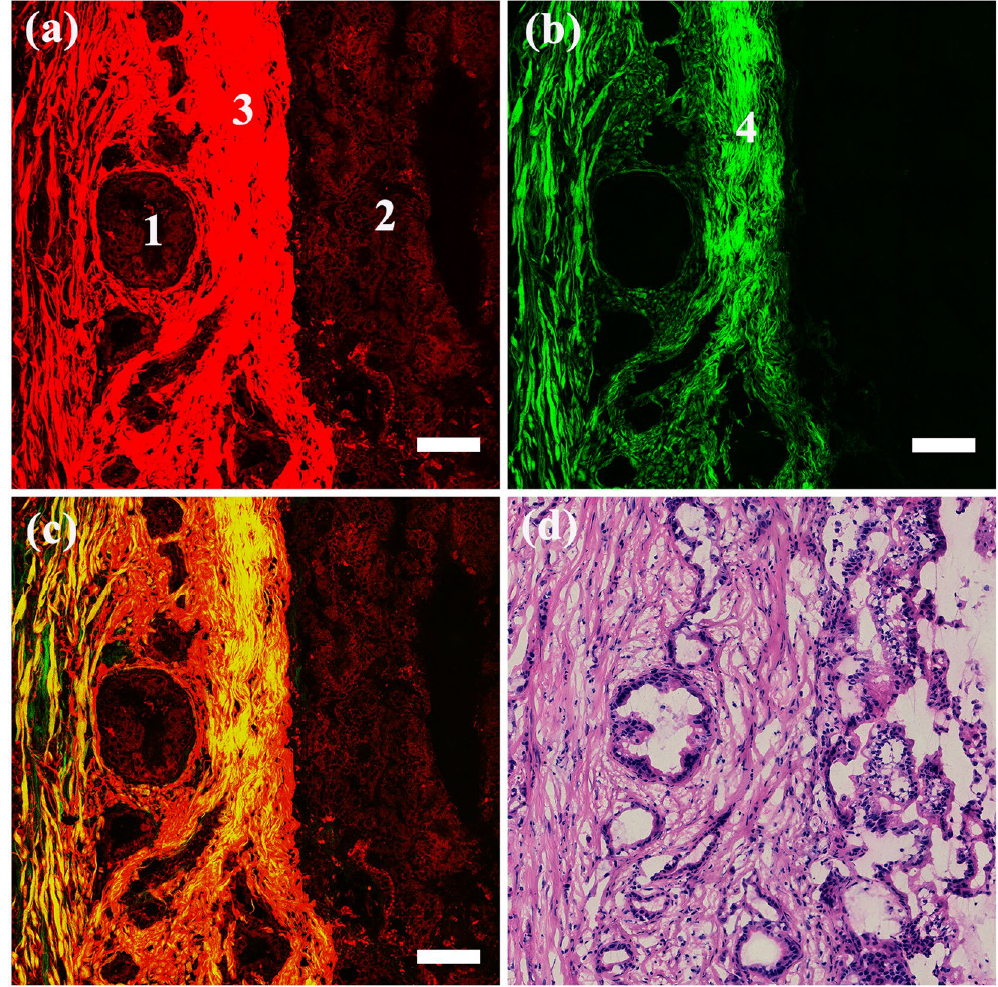
Figure 3. MPM images and the corresponding H&E-stained images of ductal adenocarcinoma in the pancreatic head. Magnification of H&E-stained image is 40 × ; Scale: 100 μ m. ( a ) TPEF image; ( b ) SHG image; ( c ) Overlay of TPEF and SHG image; ( d ) H&E-stained image. Position 1: well differentiated neoplastic gland; position 2: poorly differentiated neoplastic glands; position 3: collagen detected by TPEF signal; position 4: collagen detected by SHG